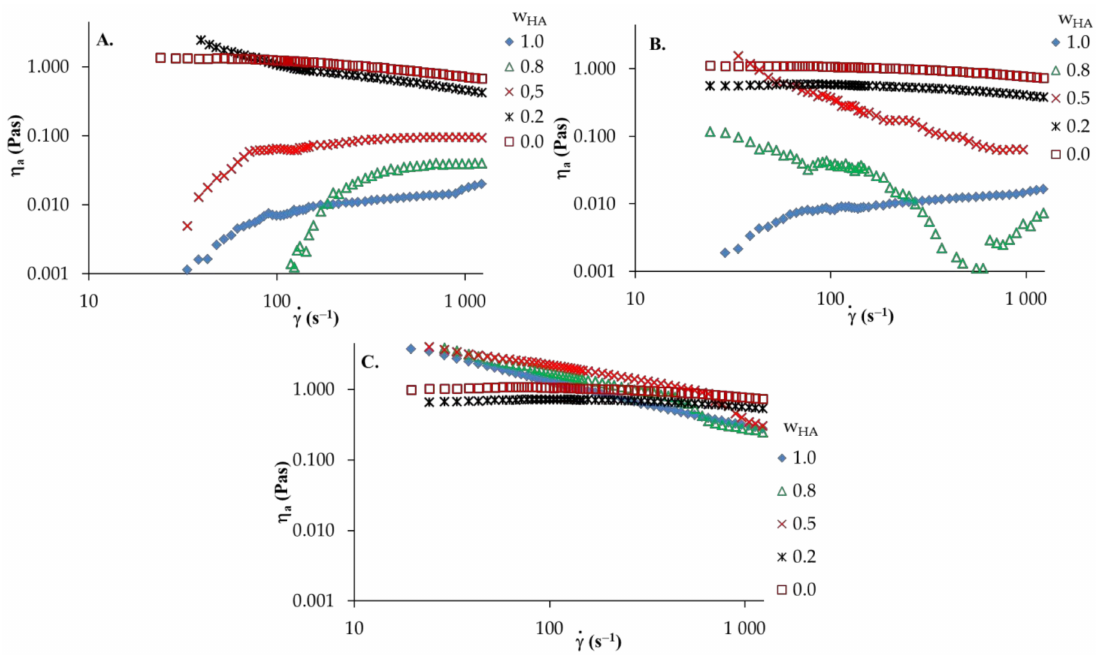
. γ of HA and PVA and their blends: ( A )